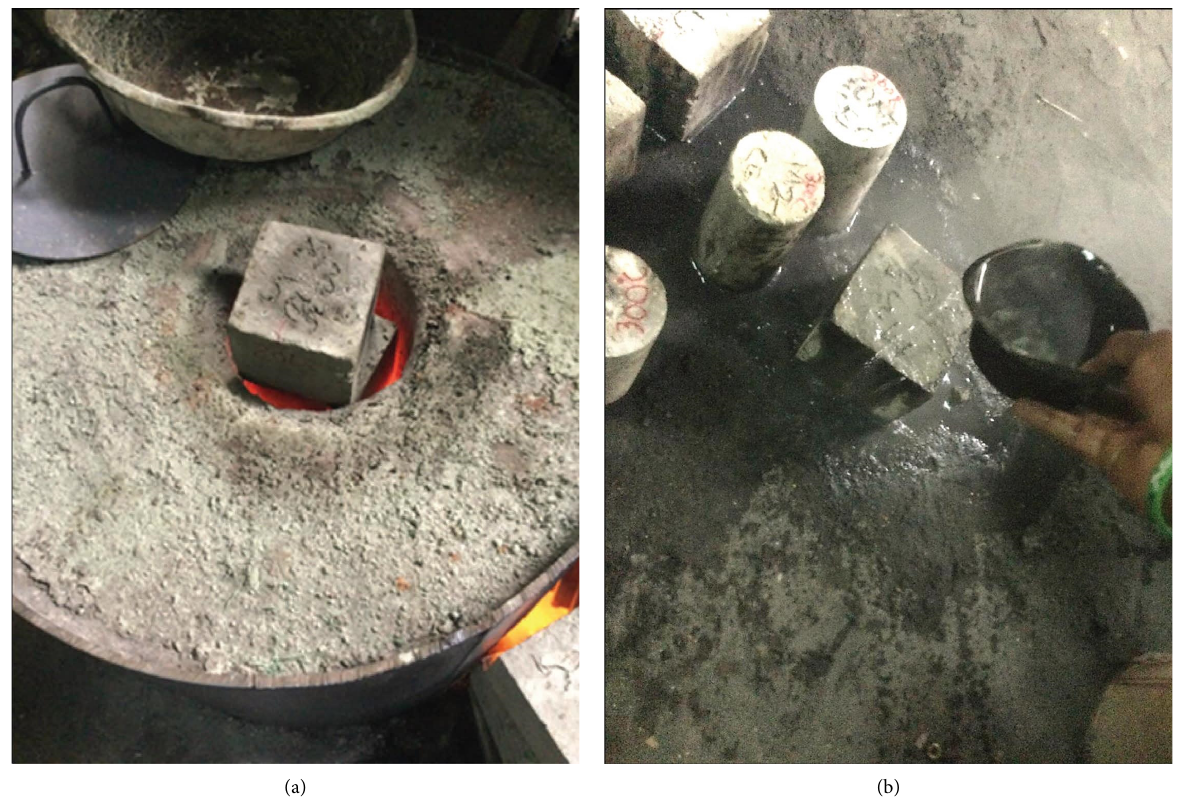
Figure 5: (a) Heating of concrete in an industrial furnace. (b) Cooling process of concrete.